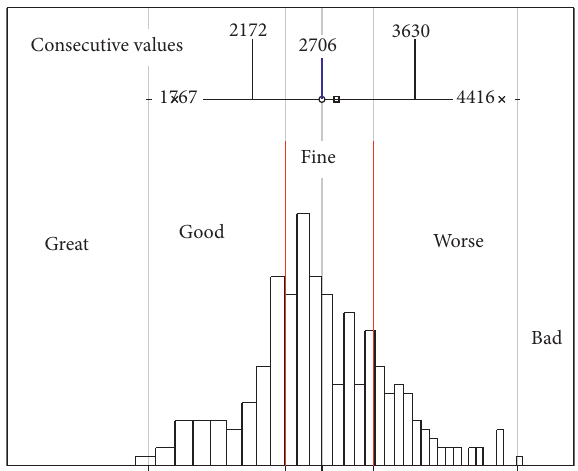
Figure 5: Consecutive values of the work-filling rate.